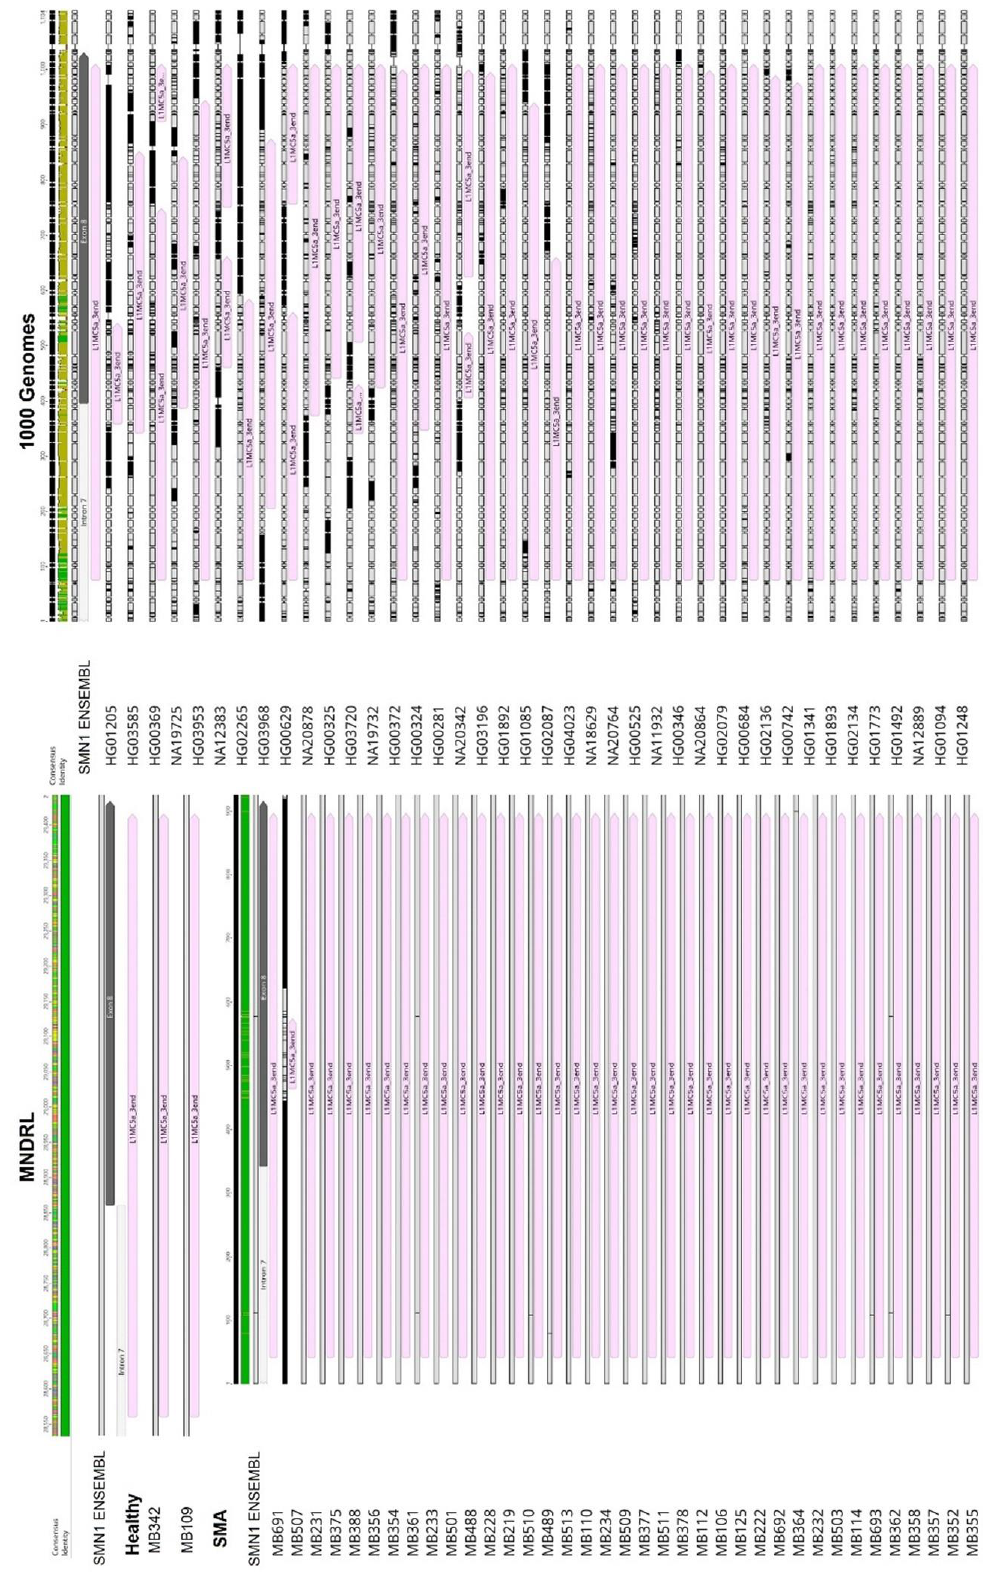
Figure 4. Comparison of SMN1 / 2 exon 8 within the sample cohort. All samples in study, inde- pendently of disease status, exhibit the L1 insertion (represented by a pink arrow) inside exon 8 (represented by a grey arrow) suggesting that the L1 element inserted in exon 8 is indeed fixed in the population and that it has a biological role in SMN1 / 2